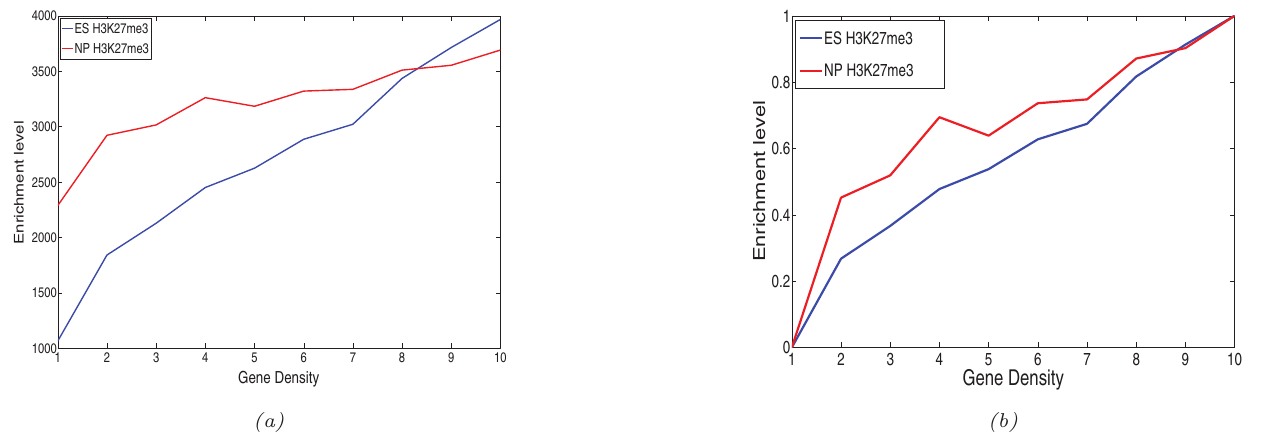
Figure 5. Enrichment level of bins with respect to gene density in a 1 Mbp region. The x axis indicates lowest to highest gene density. (a) The y axis indicates the total number of H3K27me3 ChIP-seq fragments divided by the number of Mbp regions (counts per megabase) found in each gene density. (b) The plots are re-normalized so that the y axis range is same for both ES and NP cell data. We see that the enrichment level of ChIP- seq data increases with respect to gene density for both ES and NP